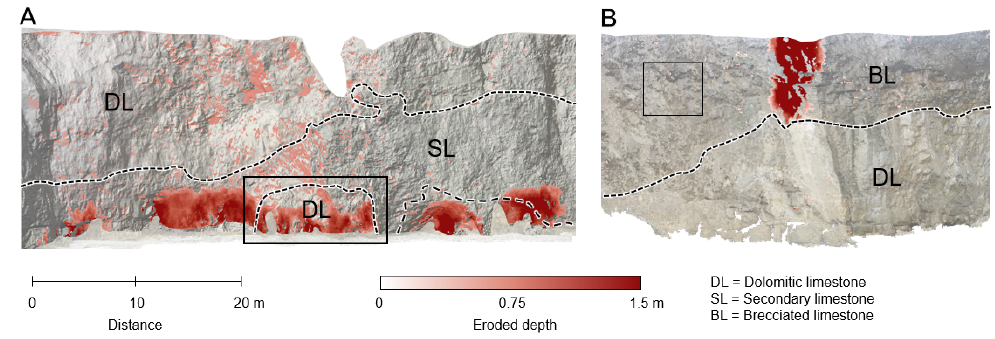
Figure 3. Example erosion depth maps for individual di ff erencing periods retrieved from digital elevation model (DEM) di ff erencing. ( A ): Extensive erosion of existing caves at the cli ff base between December 2016 and January 2017, beginning at a cli ff line distance of 0.38 km (see Figure 1). Erosion extends across both dolomitic and secondary limestones. ( B ): The largest cli ff -top failure recorded during the monitoring period, which occurred in the period of March–May 2016 at a cli ff line distance of 0.34 km (see Figure 7). In this example, the erosion scar is confined to the brecciated limestone and does not extend down into the dolomitic limestone. Background data are a semi-transparent RGB orthoimage, draped over a hill-shaded DEM. Dashed lines show lithologic boundaries. Square boxes in A and B show locations of Figure 4A,B, respectively.